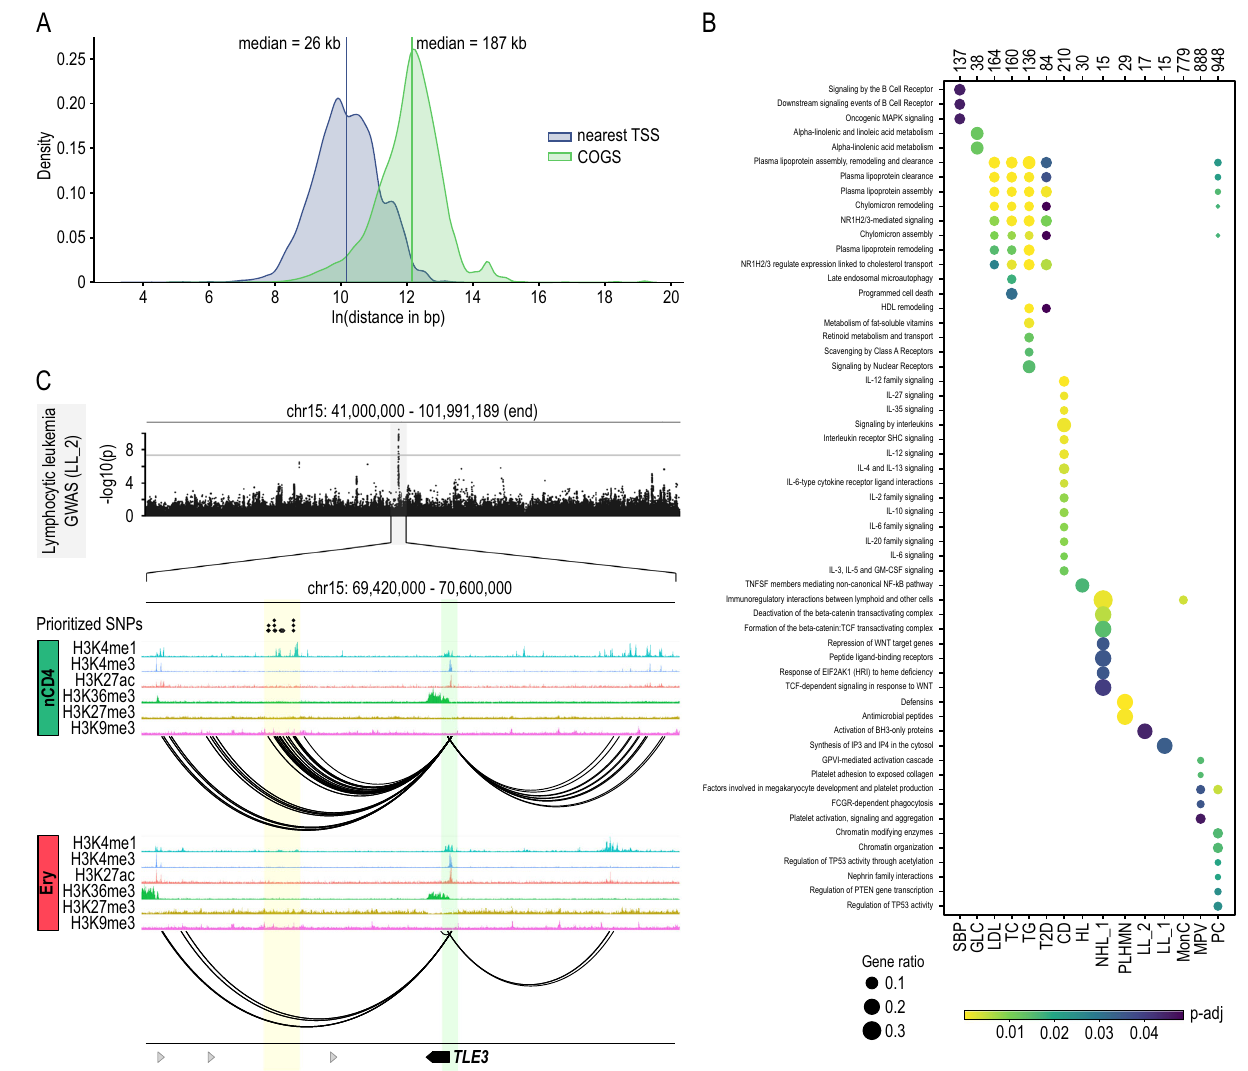
Fig. 5 | liCHi-C enables the discovery of disease-relevant genes and gene path- ways. A Density distribution of the distance between selected SNPs and the tran- scription start site (TSS) of the nearest protein-coding gene (blue) and the TSS of the gene prioritized by COGS (green). For each GWAS trait, we selected all the signi fi cantlyassociatedSNPs( P value<5×10 − 8 )interactingwithatleastoneprotein- coding gene prioritized by COGS. Coding SNPs or noncoding SNPs overlapping promoters were excluded. Vertical lines represent median distance. B Bubble plot oftraitswithsigni fi cantenrichment( P -adj<0.05)inoneormorepathwaysfromthe Reactome database. Top numbers indicate the total number of genes analyzed for eachtrait(genescore>0.5),bubblesizeindicatestheratiooftestgenestothosein